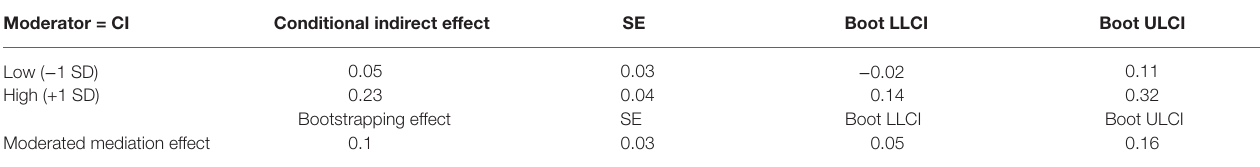
TABLE 4 | Summary of conditional indirect